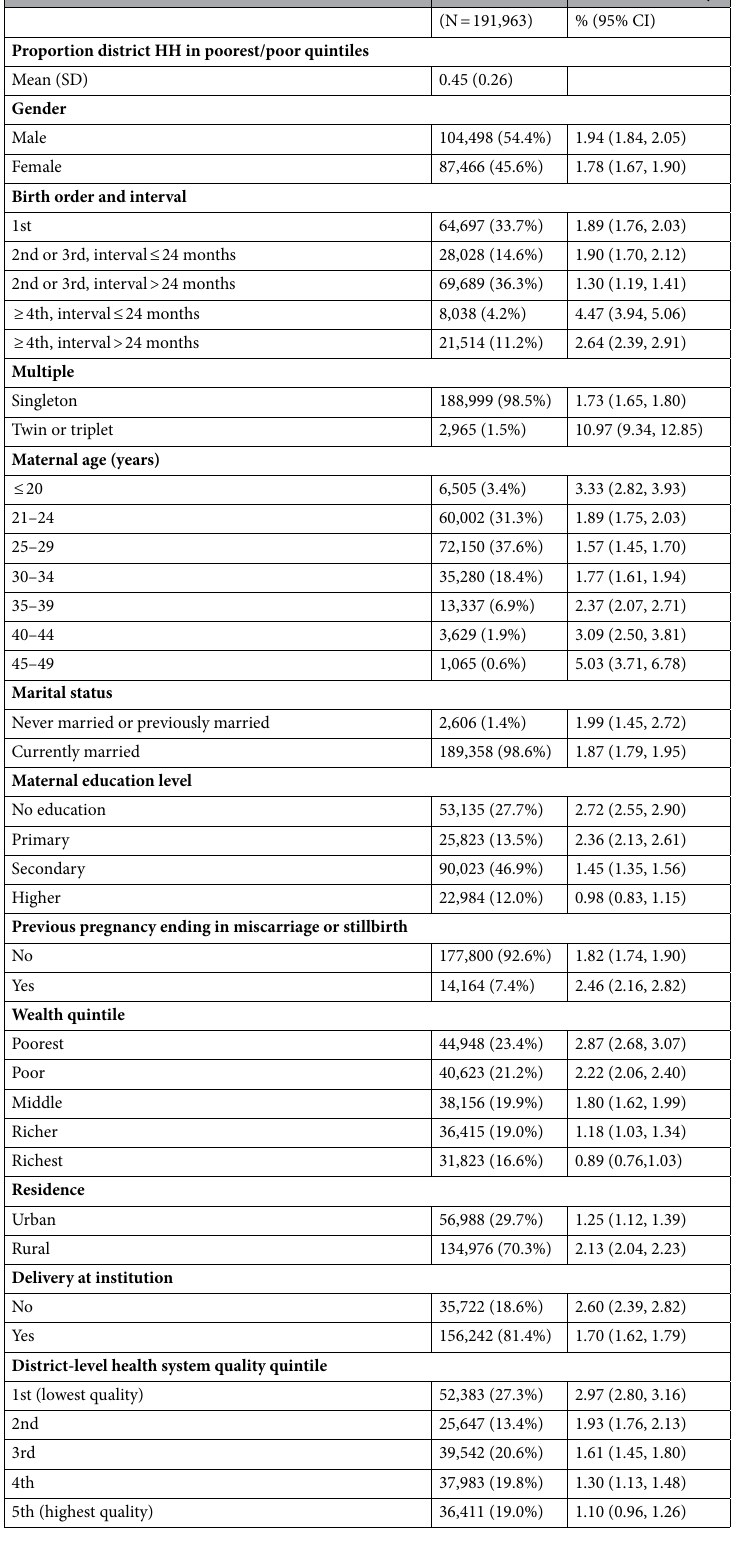
Table 1. Descriptive statistics of analytic sample (N =